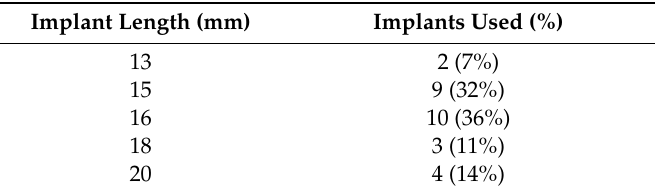
Table 4. Number (%) of di ff erent implant lengths used.